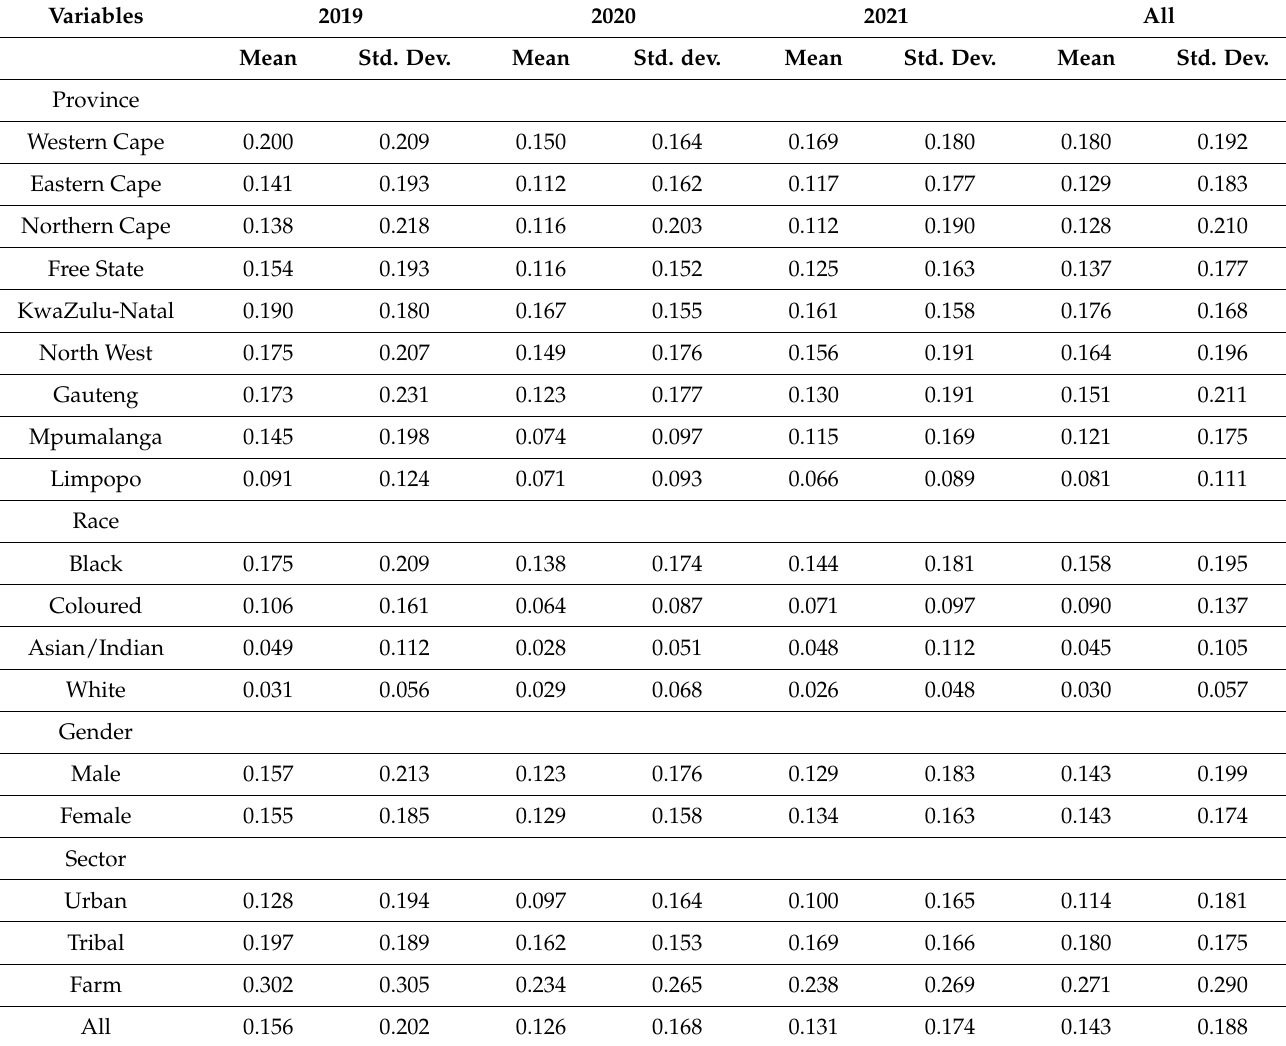
Table 1. Average MEPI across provinces, races, genders, and economic sectors in South Africa (2019–2021).